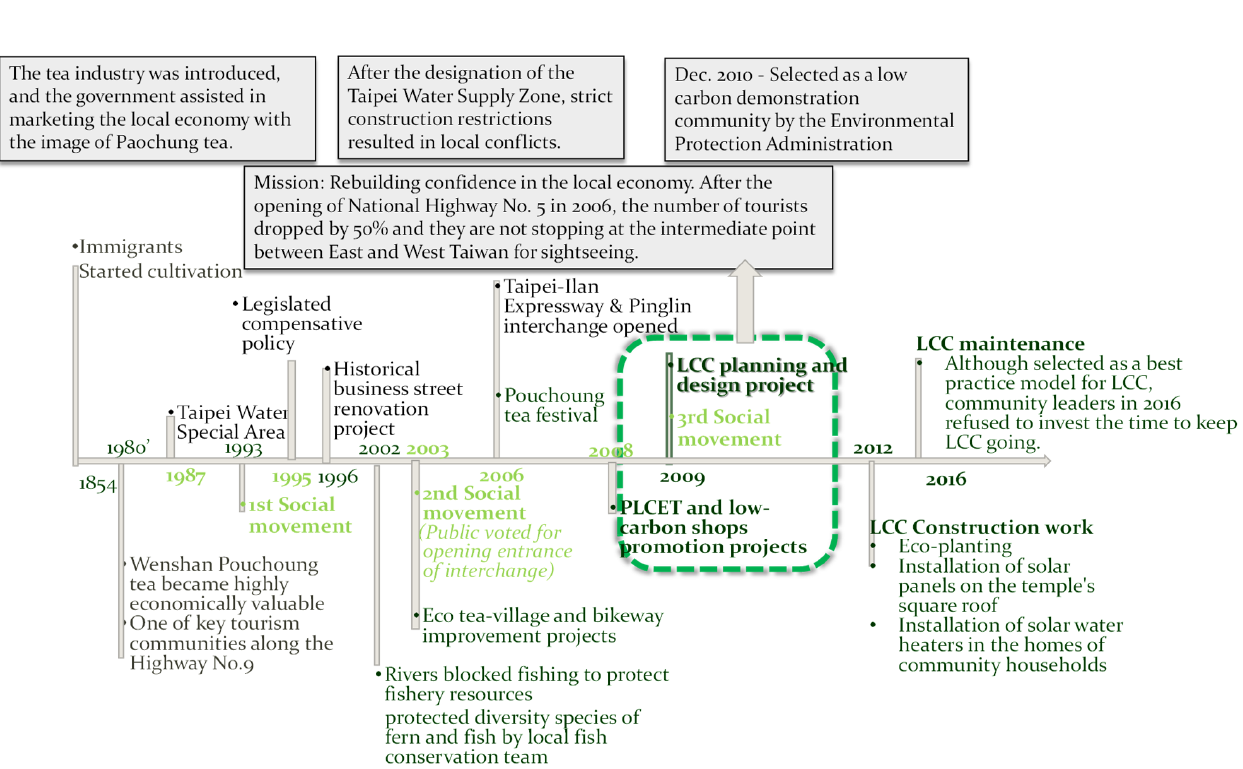
Figure 1. Timeline of Pinglin’s socioeconomic context.